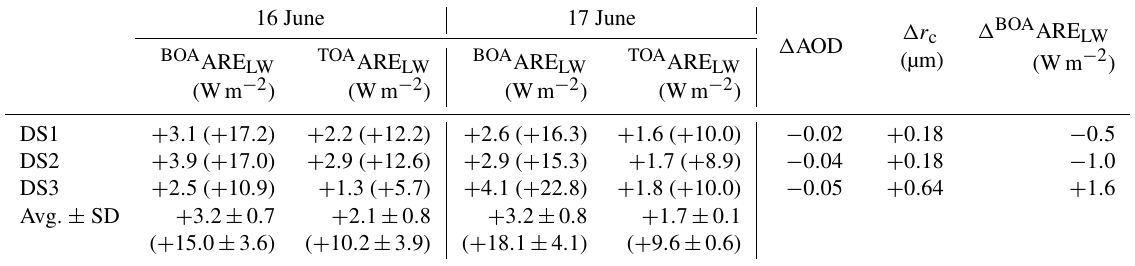
Table 7. ARE (and FE indicated between parenthesis) at the BOA and the TOA for the LW spectral range obtained with GAME using as inputs DS1, DS2, and DS3 for 16 and 17 June 2013. The averaged values and standard deviation are also included. The last three columns include variations ( (cid:49) ) in AOD, r c , and ARE at the BOA between 16 and 17 June for the three datasets.